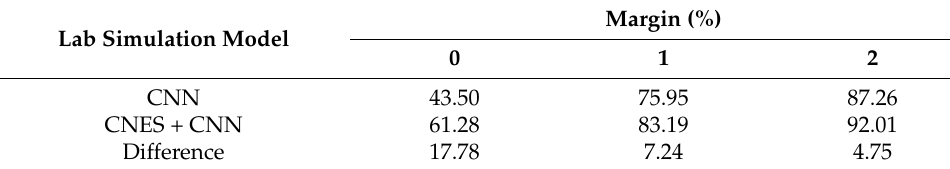
Table 4. Summary of lab simulation results.